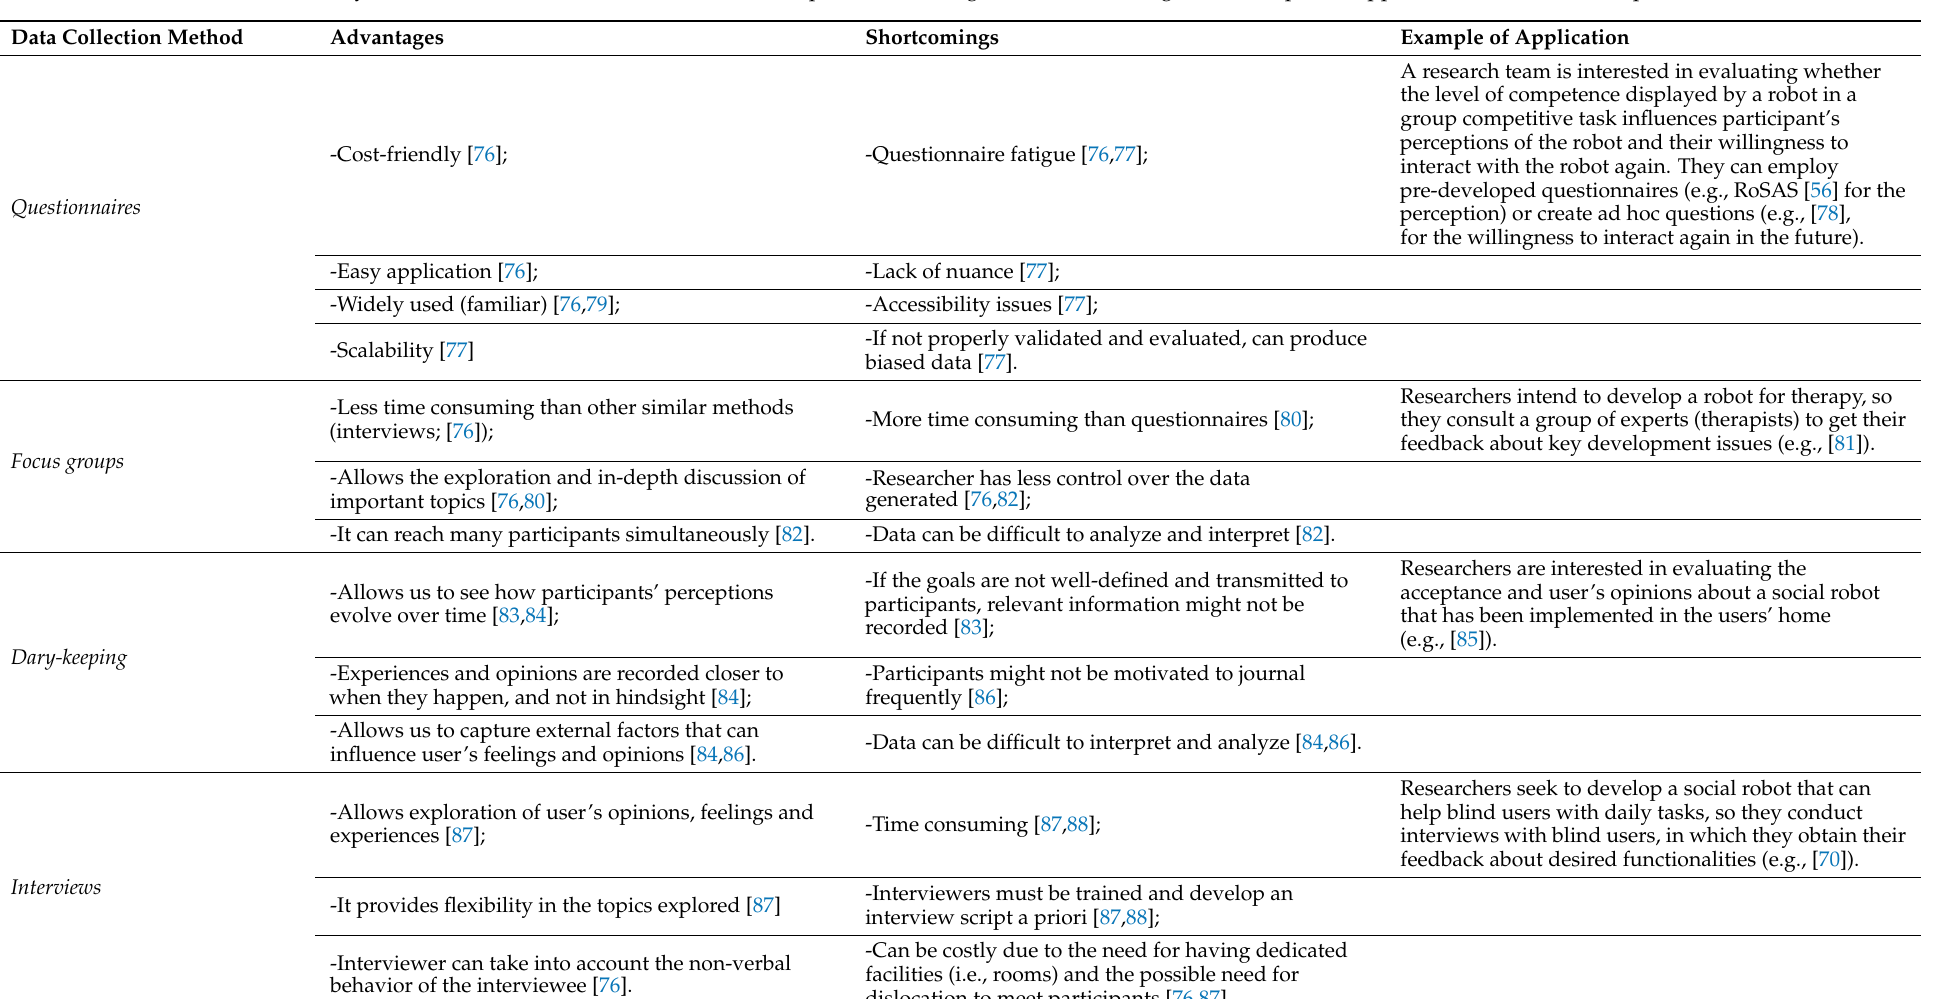
Table 1. Summary of data collection methods, some of their respective advantages and shortcomings and examples of application to HRI research